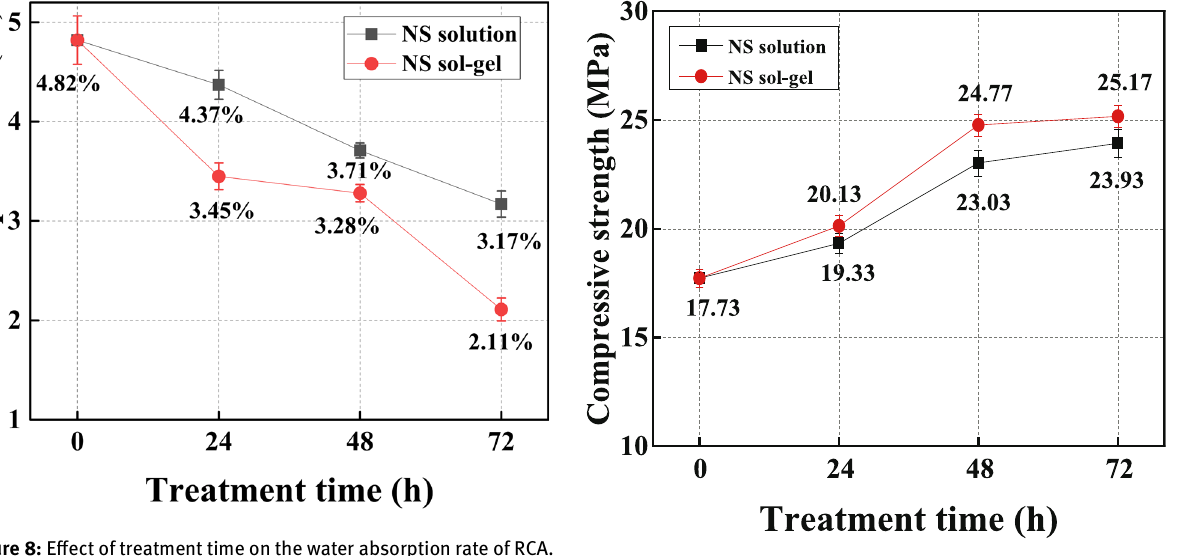
Figure 10: E ff ect of treatment time on compressive strength of rub - berised mortar.